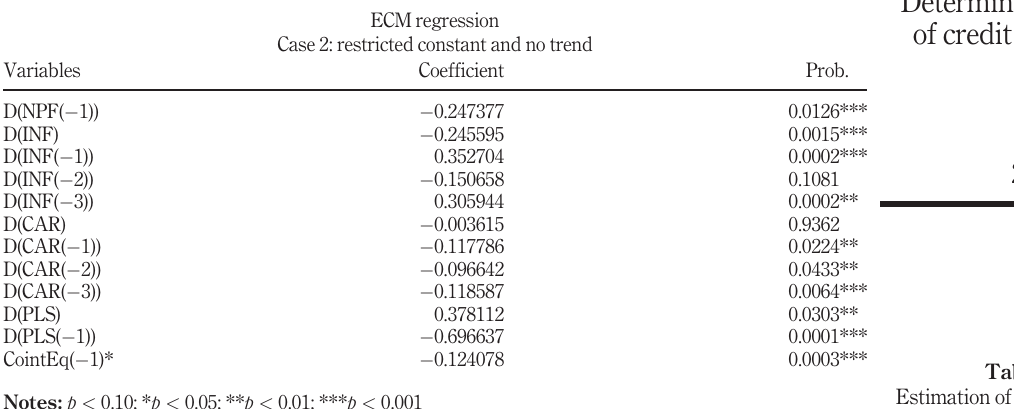
Table 3. Estimation of short-